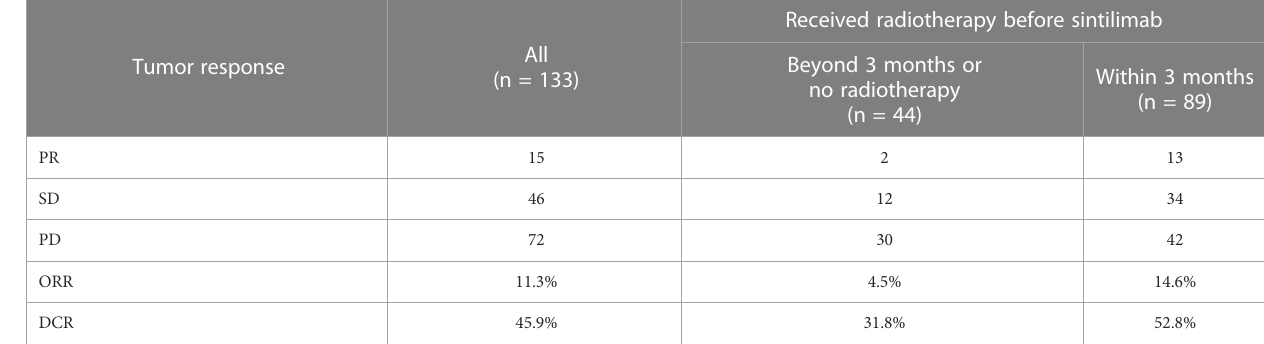
TABLE 3 Tumor response in advanced